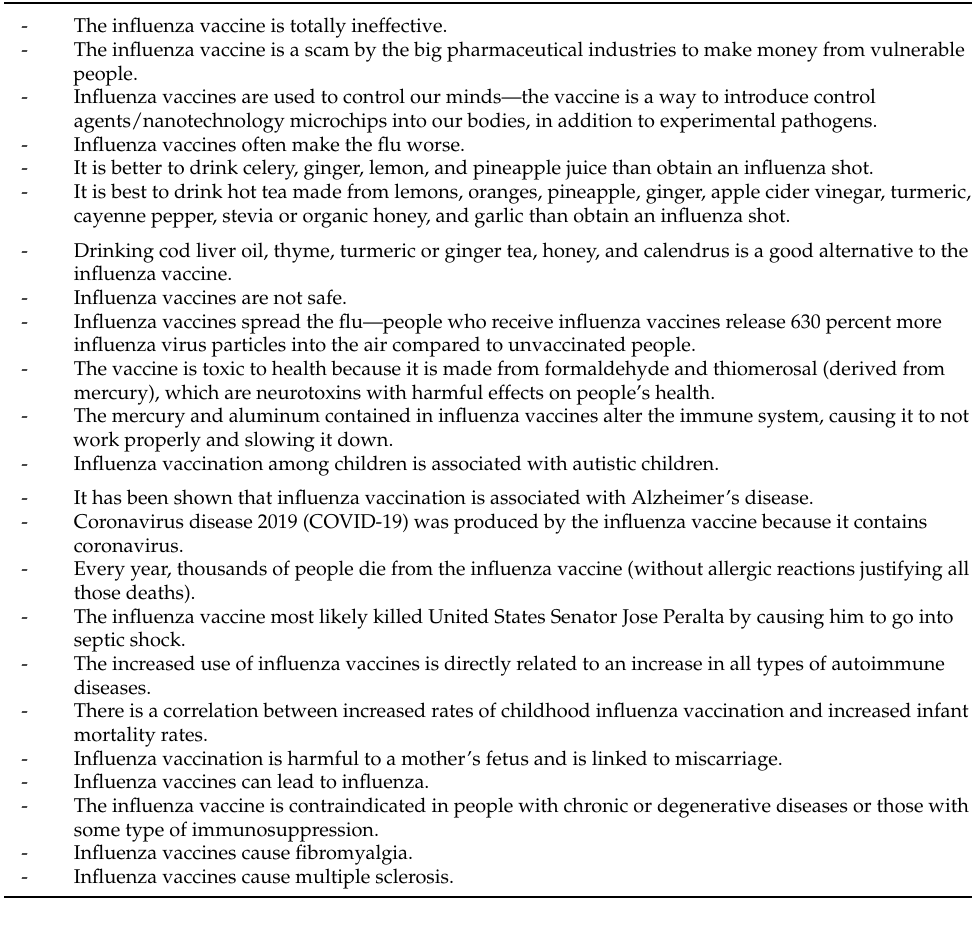
Table 4. Hoaxes and conspiracy theories detected in the